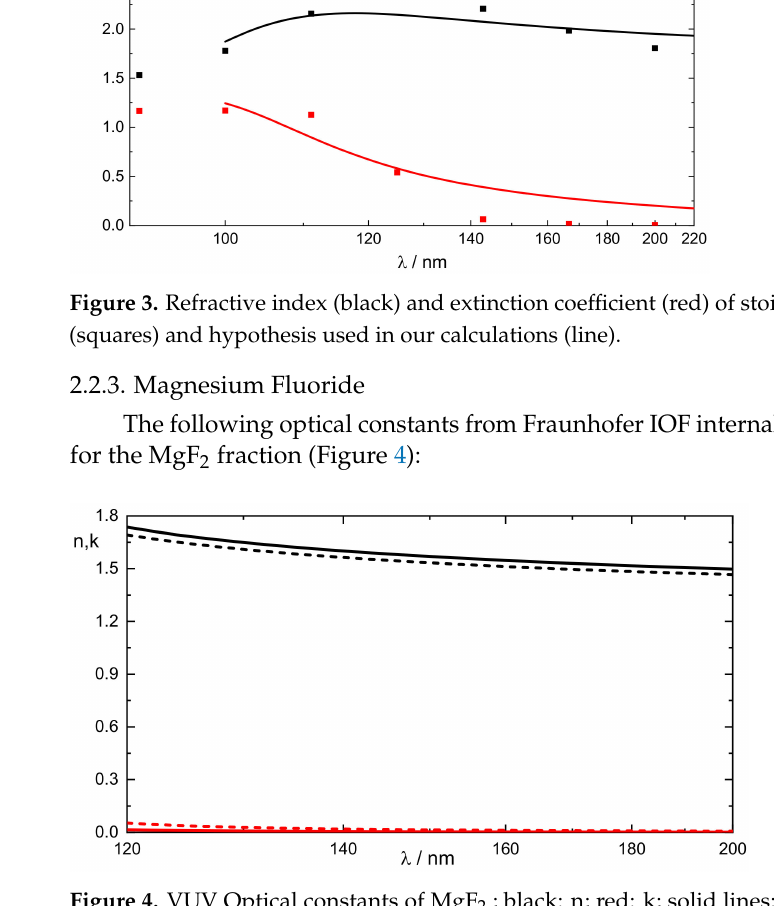
Figure 4. VUV Optical constants of MgF 2. ; black: n; red: k; solid lines: deposition at 225 ◦ C, dash: deposition at room temperature.